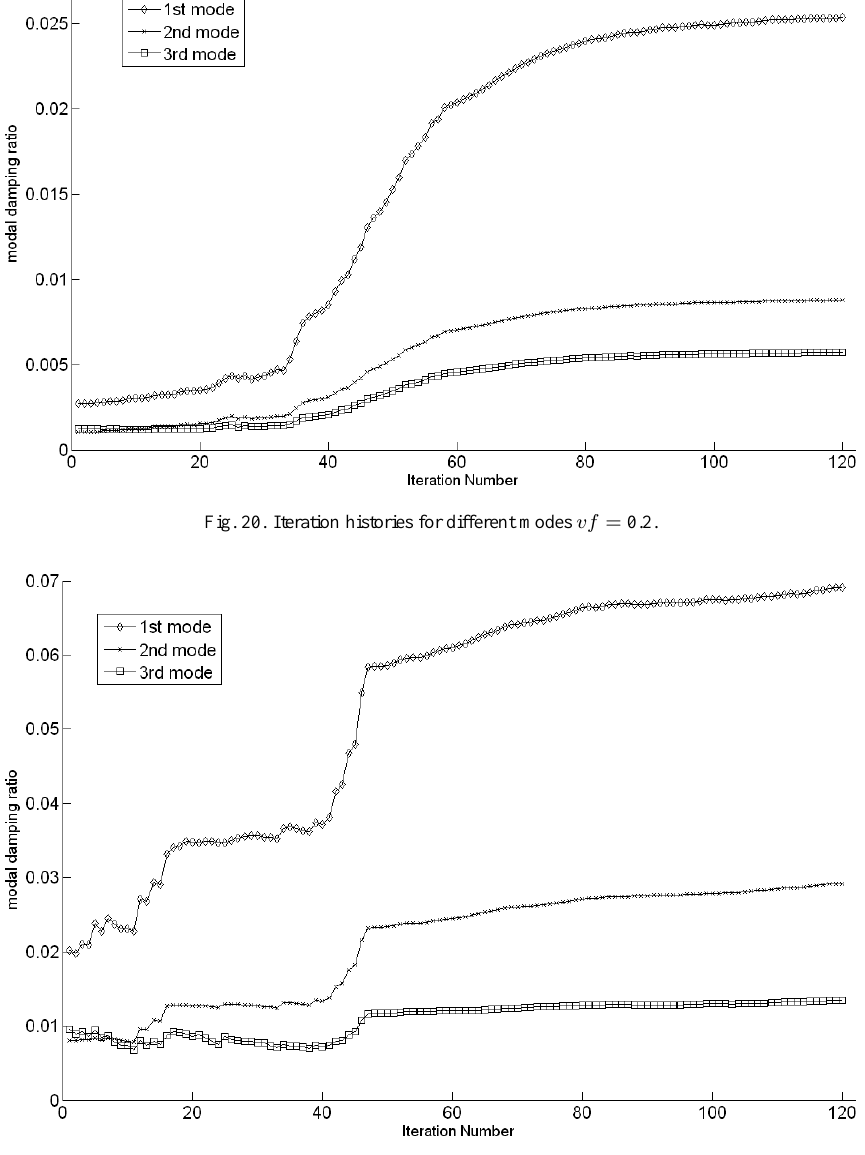
Fig. 21. Iteration histories for different modes vf =